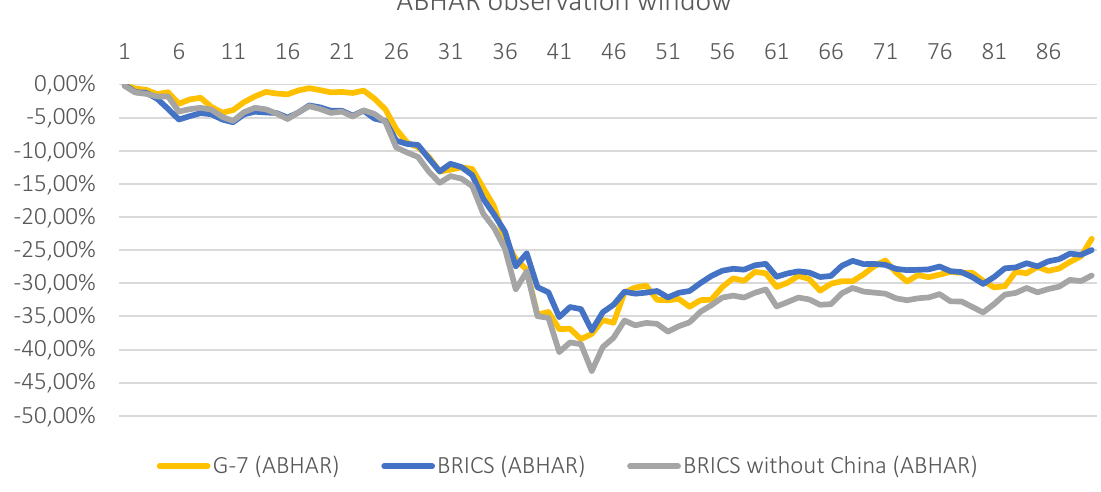
Figure 3. ABHAR values in the observation window for G-7 and BRICS